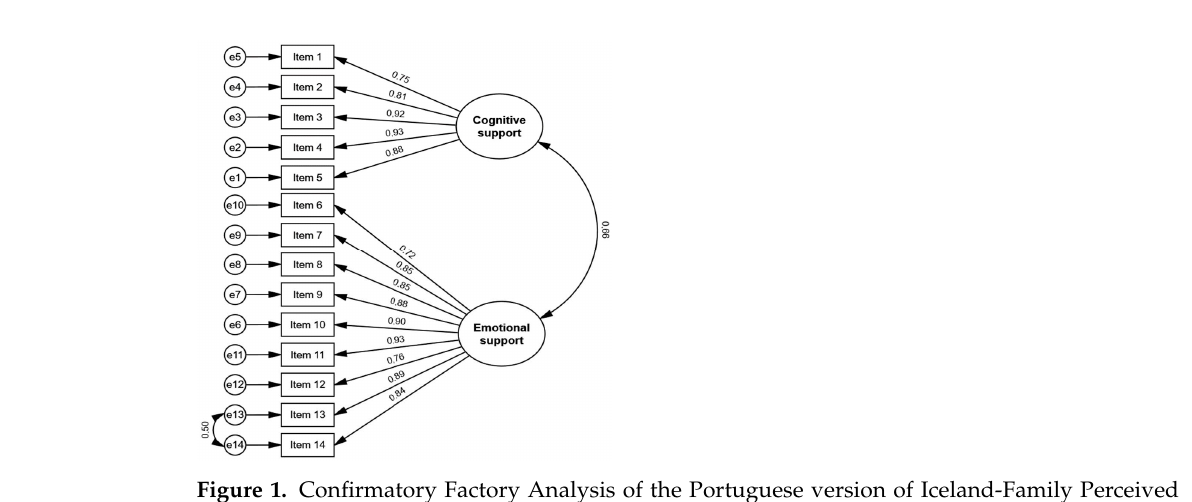
Figure 1. Confirmatory Factory Analysis of the Portuguese version of Iceland-Family Perceived Support Questionnaire.